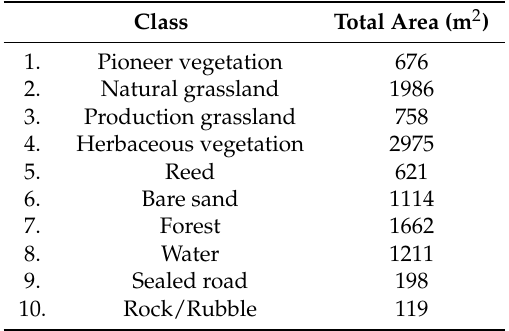
Table 1. Total area of reference polygons per